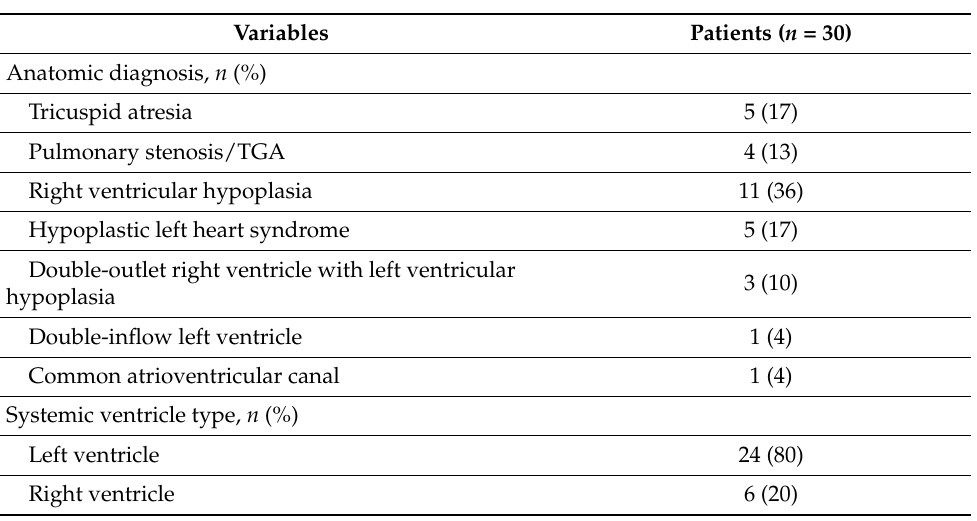
Table 2. Baseline characteristics of patients after the Fontan